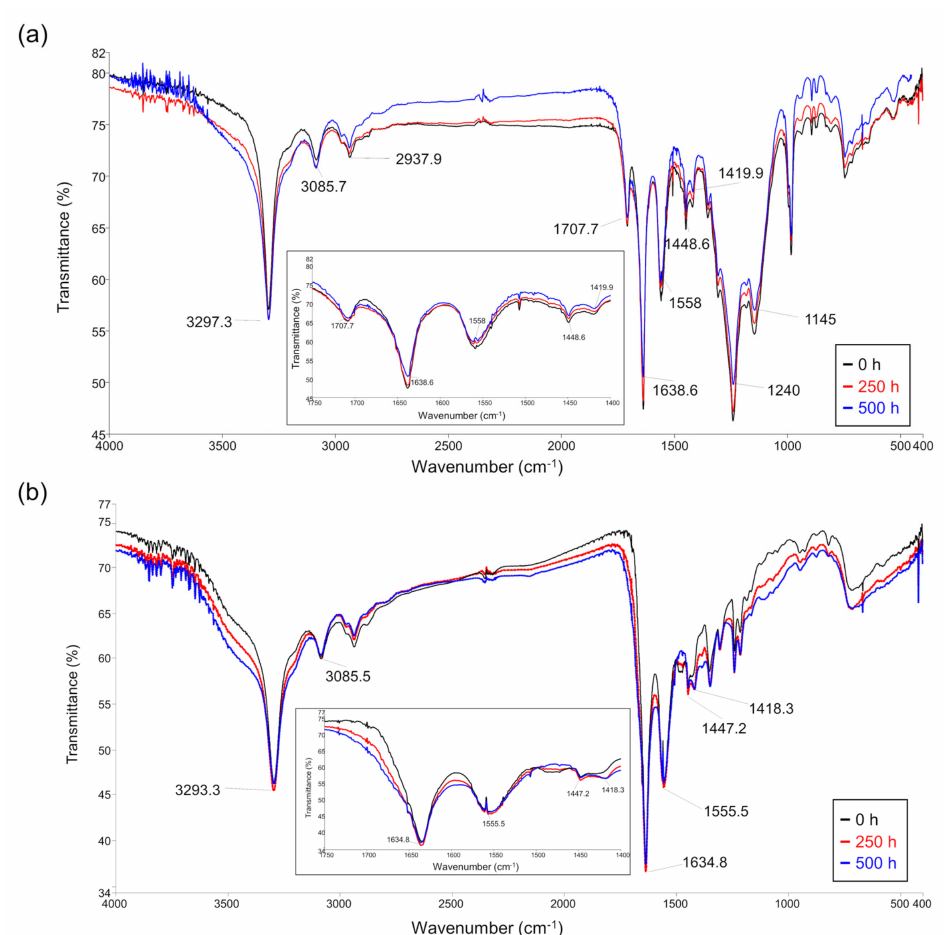
Figure 2. FT-IR spectra before and after different times of UV irradiation of ( a ) SC2-PFPE and ( b ) SC2. In the insets, a detail of the 1750–1400 cm − 1 region is reported. Table 3. WIE of fluorinated coatings on Lecce stone specimens after different times (t) of UV irradiation. WIE was determined after 30 min and 1 h of capillary water absorption. NT means uncoated specimen.